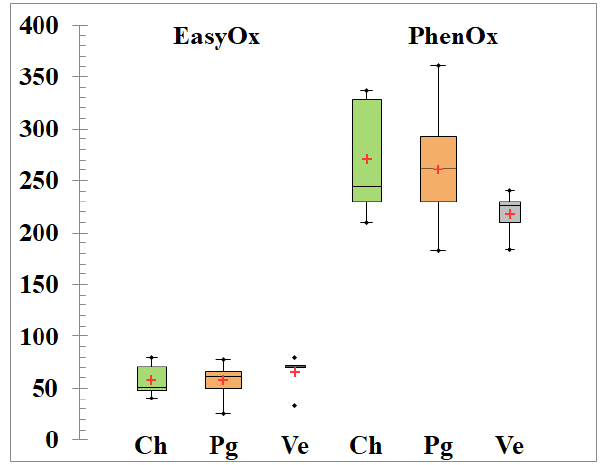
Figure 4. Box plot of EsyOx and PhenOx indexes for Chardonnay (Ch), Pinot gris (Pg) and Vermentino (Ve) grapes during alcoholic fermentation at 17 °C.